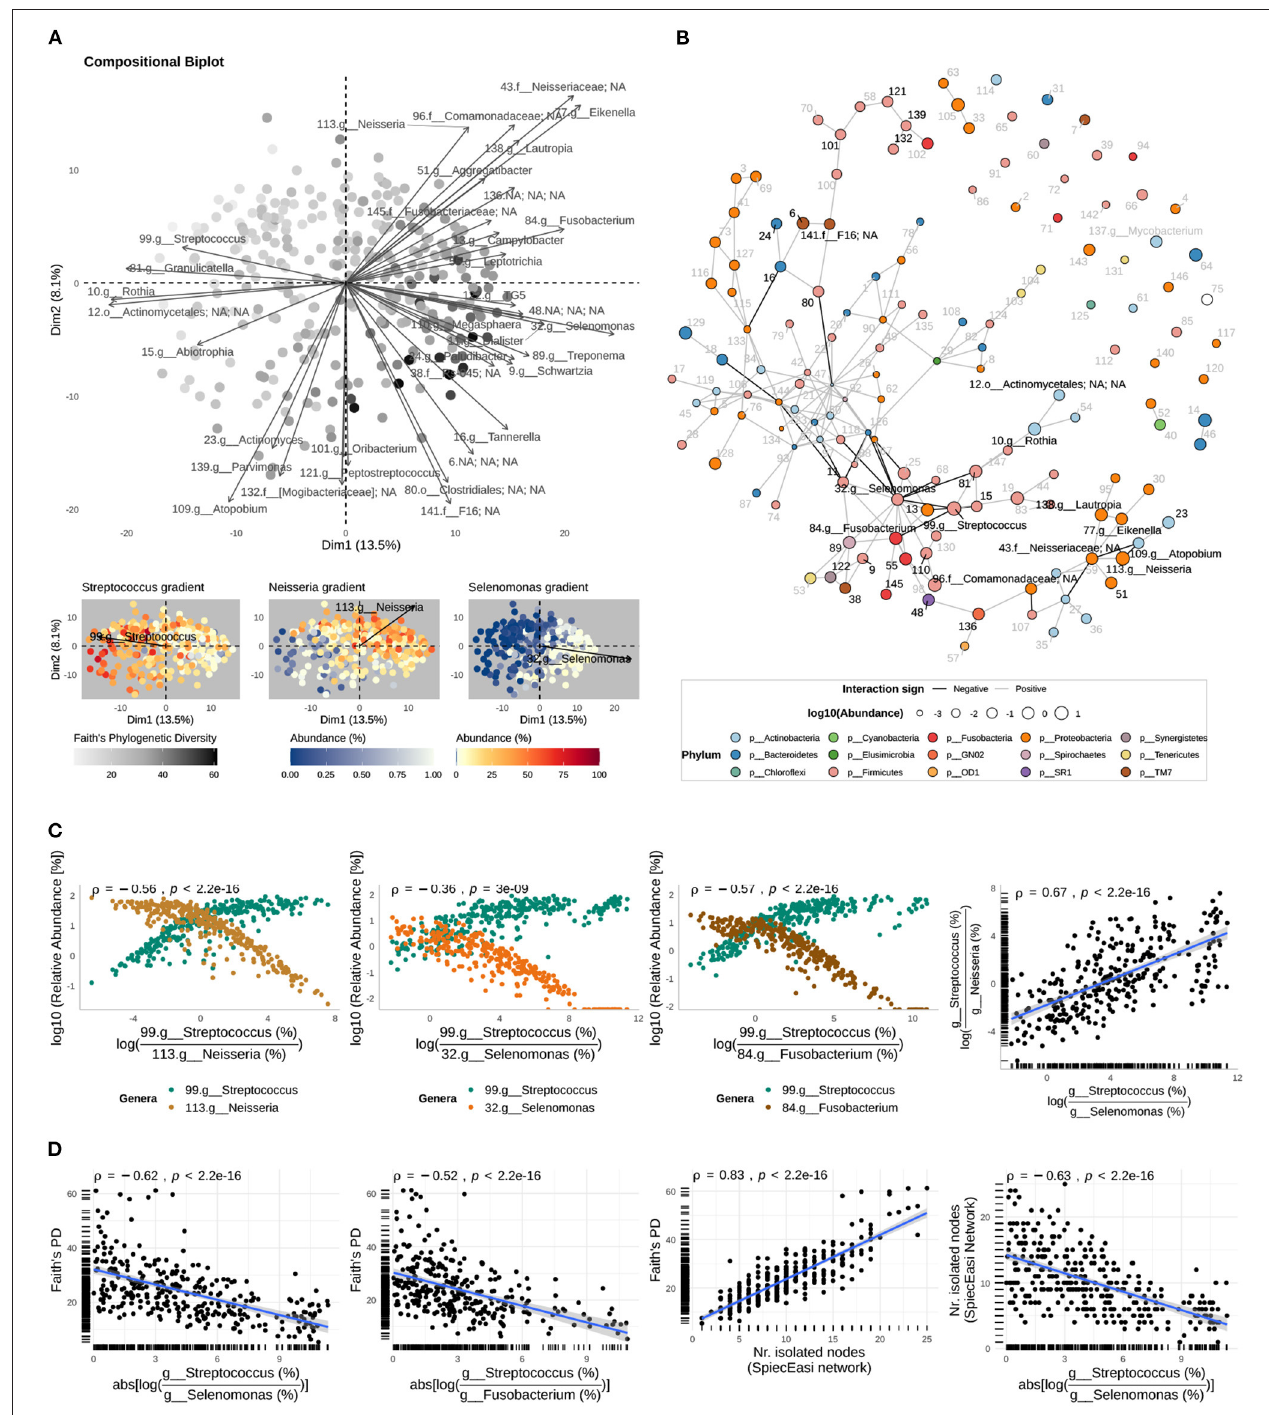
FIGURE 3 | Genus-level community interactions. (A) Relative variation biplot of genus-level community compositions (centered log-ratio transformed) shows the relative variation of the log-ratios for the top 35 taxa (arrows, taxa best represented by the axes of the biplot), and sputum samples (dots); the length of the imaginary line connecting the tips of two arrows, representing two taxa, is proportional to the variation of the log-ratio of the corresponding abundances; sputum samples are colored by the Faith’s phylogenetic diversity, and the relative abundances of genera Streptococcus , Neisseria , and Selenomonas . (B) Interaction network inferred with the SParse InversE Covariance Estimation for Ecological ASociation Inference (SPIEC-EASI) method where nodes represent genera, colored by the corresponding phylum, and of sizes corresponding to the relative abundance (%) averaged across sputum microbial assemblages and in logarithmic scale; we display the labels